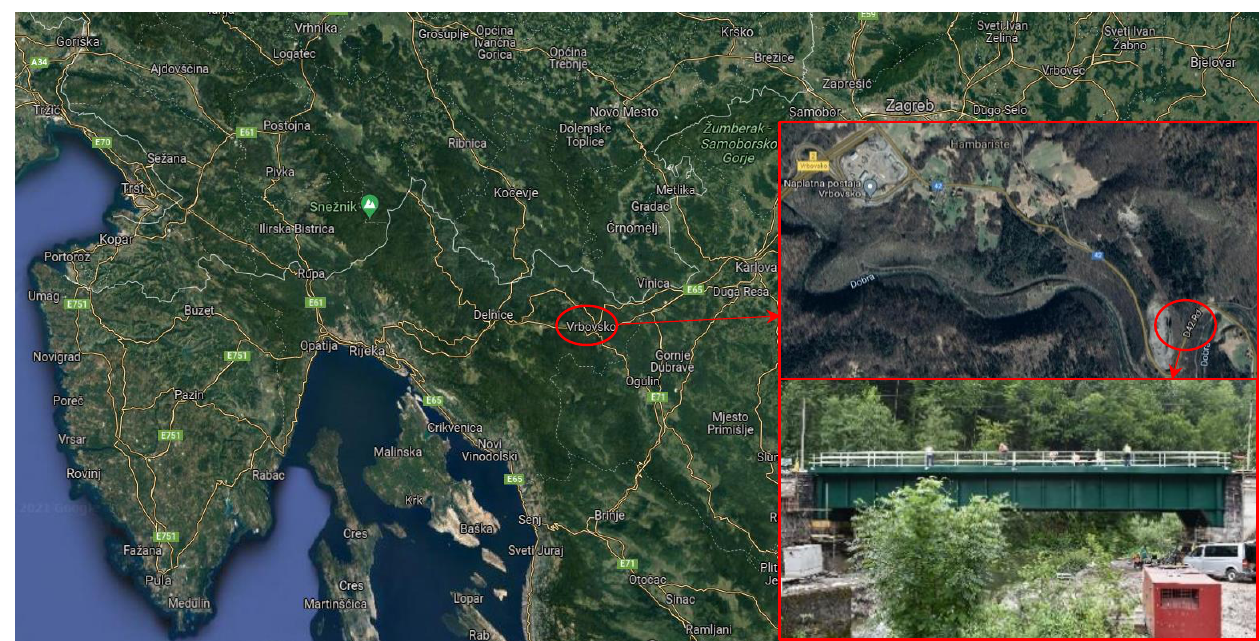
Figure 6. Location of the railway bridge Kloštar over the river Dobra near the city Vrbovsko in the central part of the Republic of Croatia and the bridge itself.